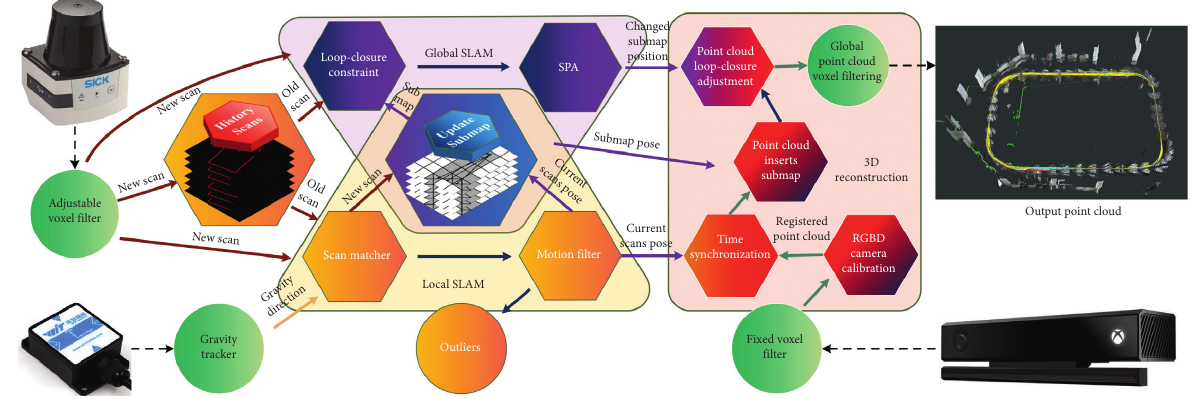
Figure 4: Overview of the 3d scenario construction system.